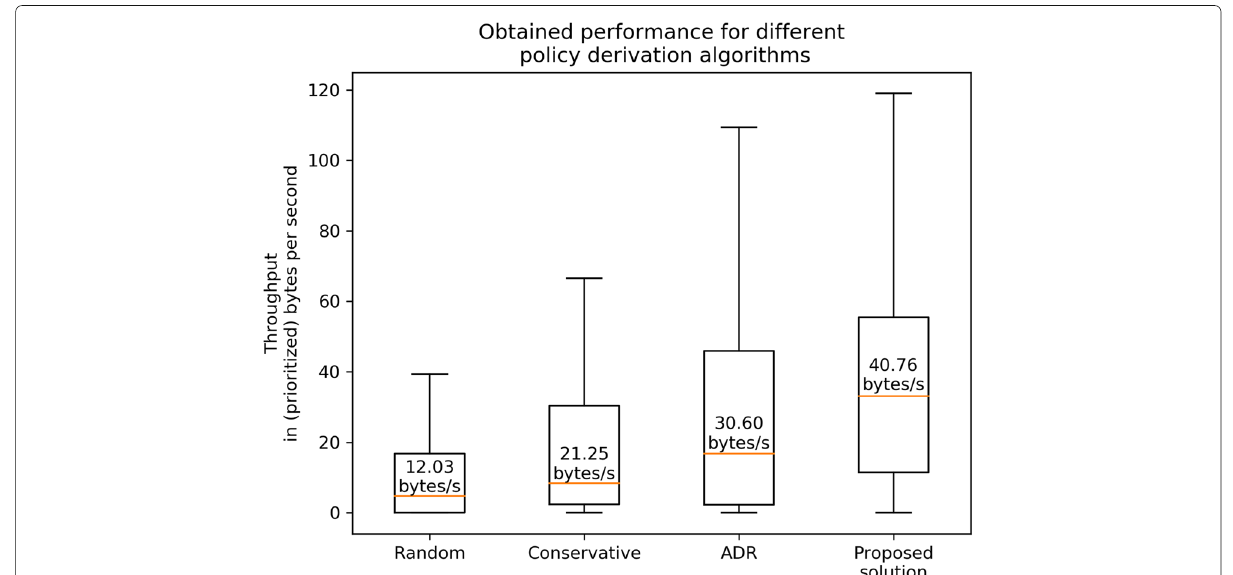
Fig. 4 Throughput values for different policies. Box plot of the throughput values obtained for 500 randomly generated nodes when the 4 policy derivation algorithms are employed. The “proposed solution” solves Eq. 6 with the SA algorithm. Average obtained throughput is also indicated in the